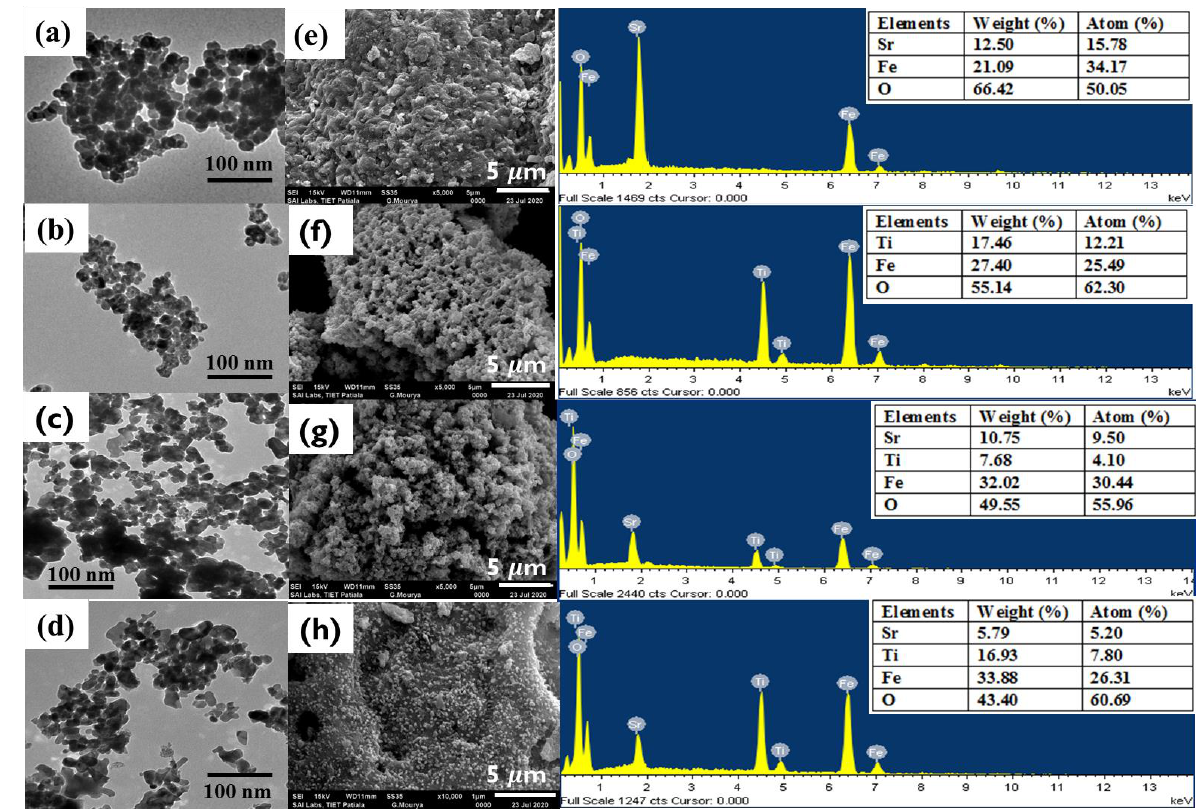
Figure 3. TEM and SEM-EDS images of ( a , e ) SrFe 2 O 4 , ( b , f ) TiFe 2 O 5 , ( c , g ) Sr 0.7 Ti 0.3 Fe 2 O 4.3 and ( d , h ) Sr 0.4 Ti 0.6 Fe 2 O 4.6.